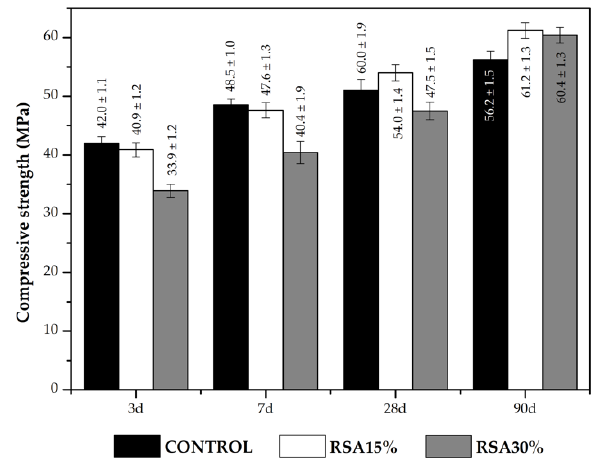
Figure 13. Compressive strength of the control and PC/RSA mortars versus curing time. Figure 13 represents compressive strength evolution versus curing time. The adjust- ment parameters are shown in Table 7. Mortar Table 7. Parameters from the compressive strength fitting.